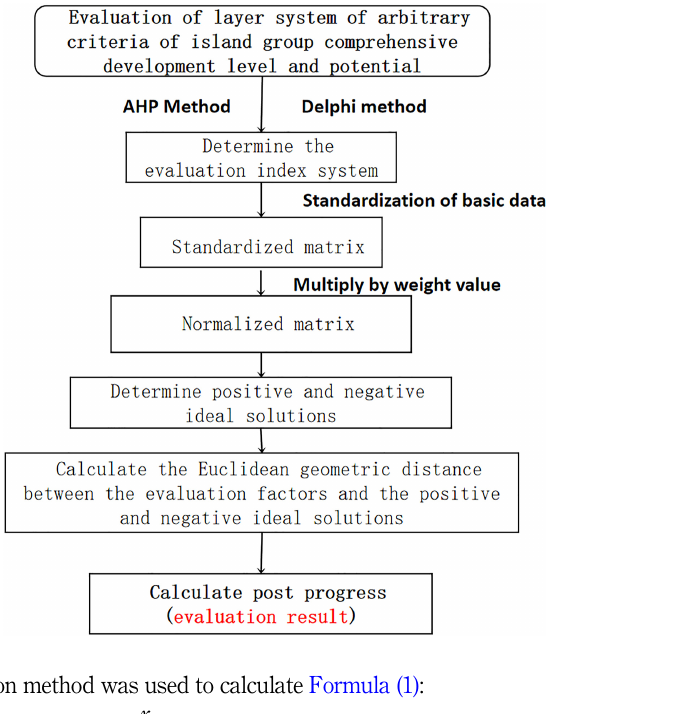
Figure 2. TOPSIS evaluation flow